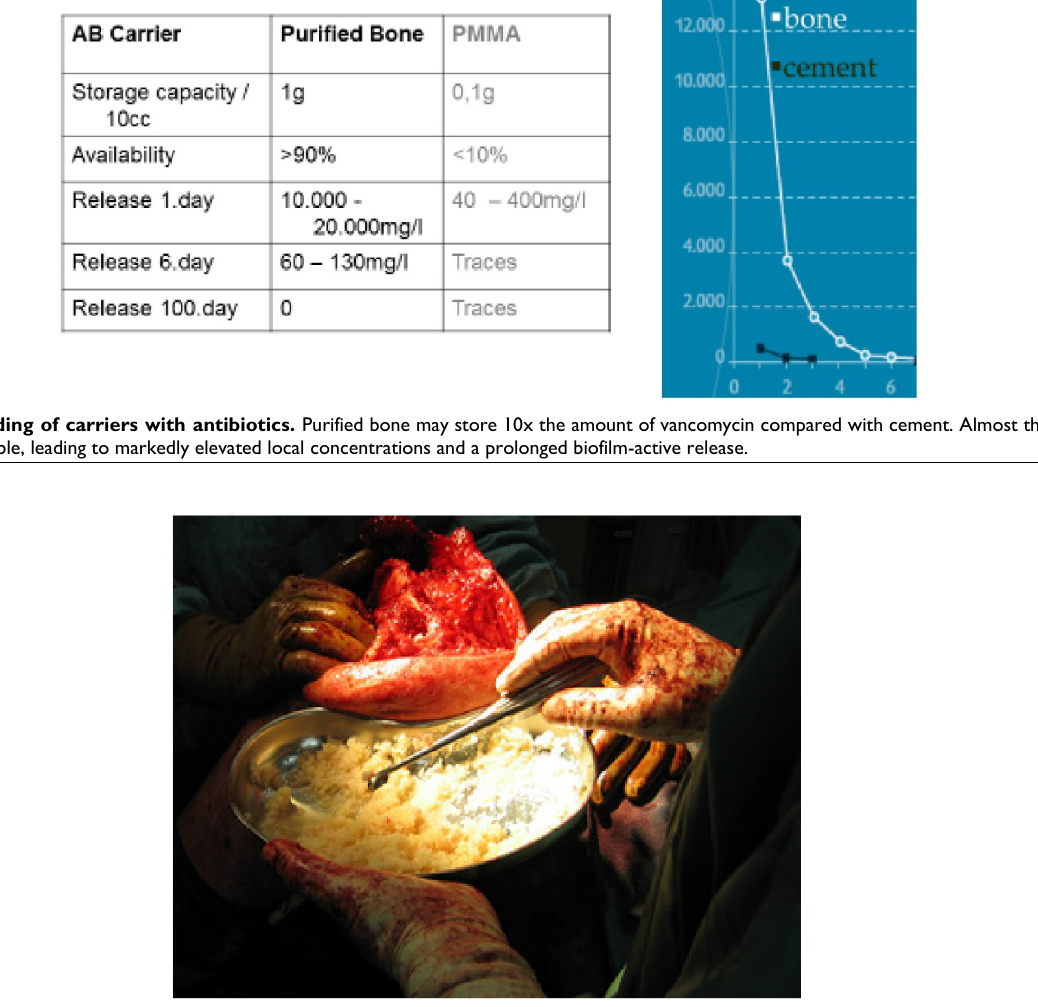
Figure 4. Antibiotic impregnated cancellous bone (Osteomyin™). Granules with a median size of 5mm in the re-hydrated condition provide a mouldable mass suitable for impaction